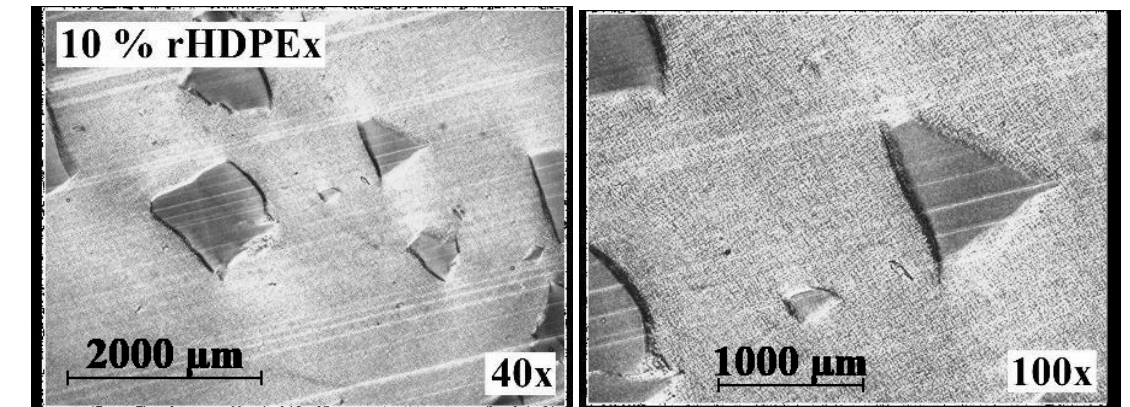
Figure 19. Microtome cuts of Mixture